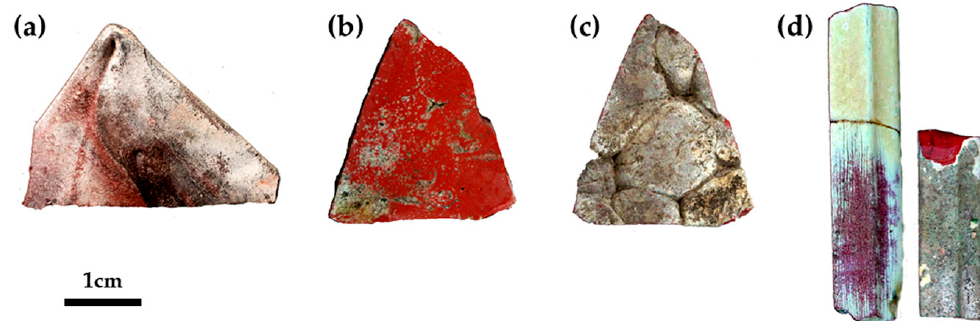
Figure 1 . Technique used to manufacture the sectilia —thin sheets stretched at the corner with visible tools markers ( a ); thick sample with flat surface ( b ) and composed by an ensemble of several canes ( c ), and visible on the back of; cast in a mould technique ( d ). The white and green layers on the surface due to the weathering of the is due to the weathering of the glass.